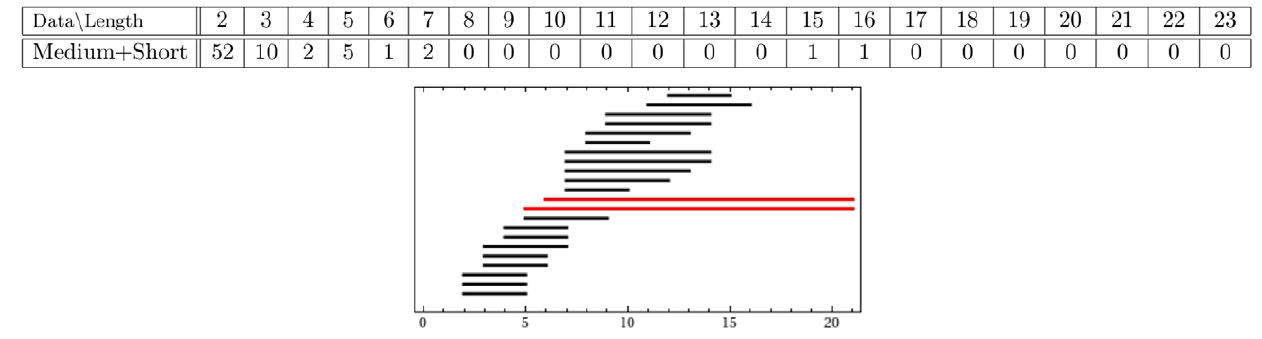
Figure 5. b 1 -persistence intervals (only lifespans w 2 are displayed) for the reduced proximal combined medium + short data set.